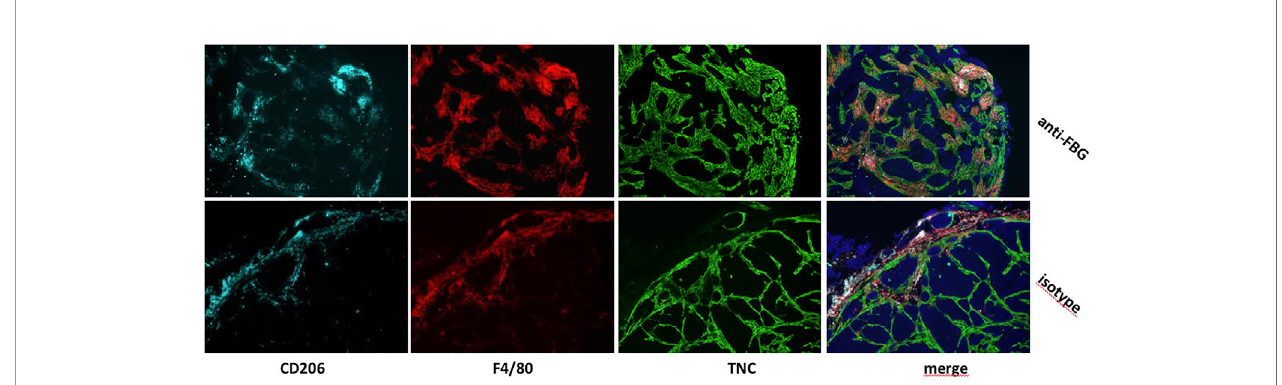
FIGURE 2 | In vivo blockade of the FBG domain of tenascin-C diminishes TAM numbers and restrict their presence to tumor edge in a mammary tumor model. Mammary tumors from mice that were treated with a blocking anti-FBG antibody (upper panels) or a control isotype (lower panels) were collected 21 days after engraftment and stained with anti-CD206 (light blue), anti-F4/80 (red), and anti-TNC